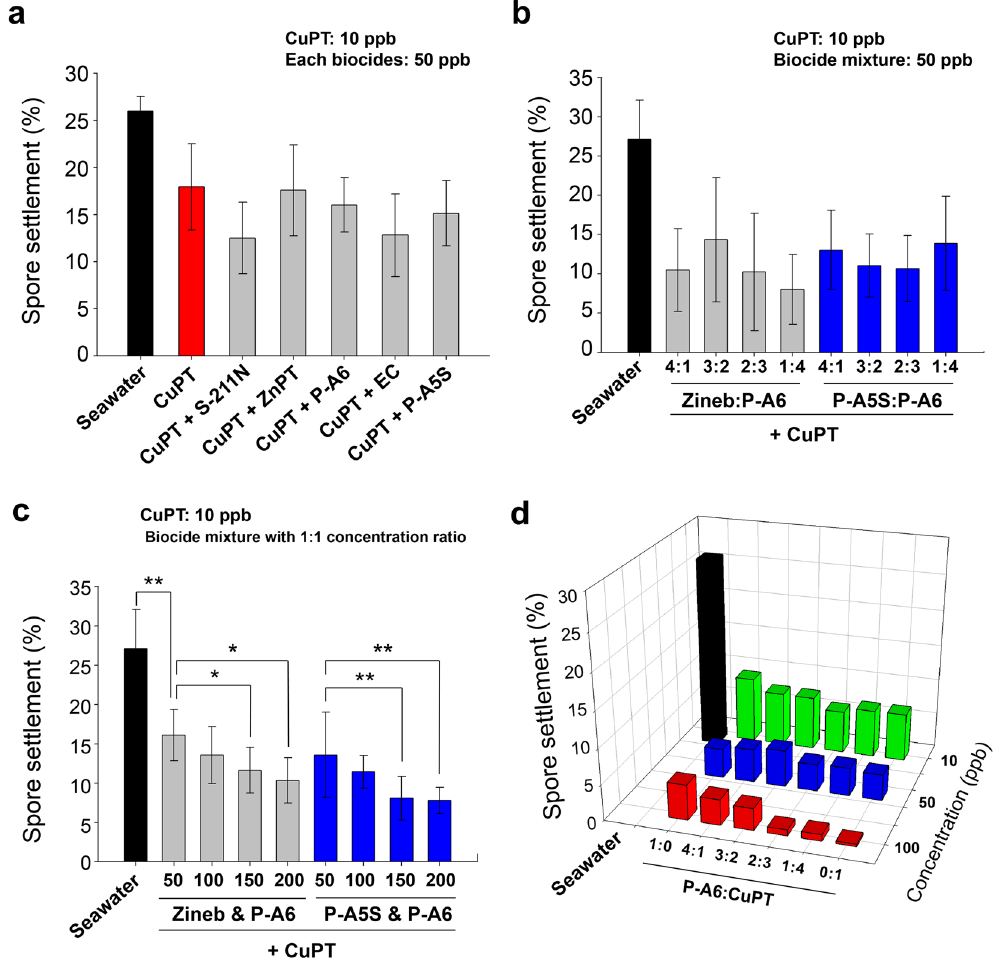
Figure 3. Settlement efficiency of Ulva spores in natural seawater containing a mixture of biocides. All of the p -values were < 0.001 between natural seawater and biocide solutions, while no significant difference was found between different biocides in ( a and b ) with n = 15. Some p -values below 0.01 ( * ) and 0.001 ( ** ) with n = 15 are represented in ( c ). The error bars (standard deviations) and p -values in ( d ) are shown in Supplementary Figures 2–4 (n =